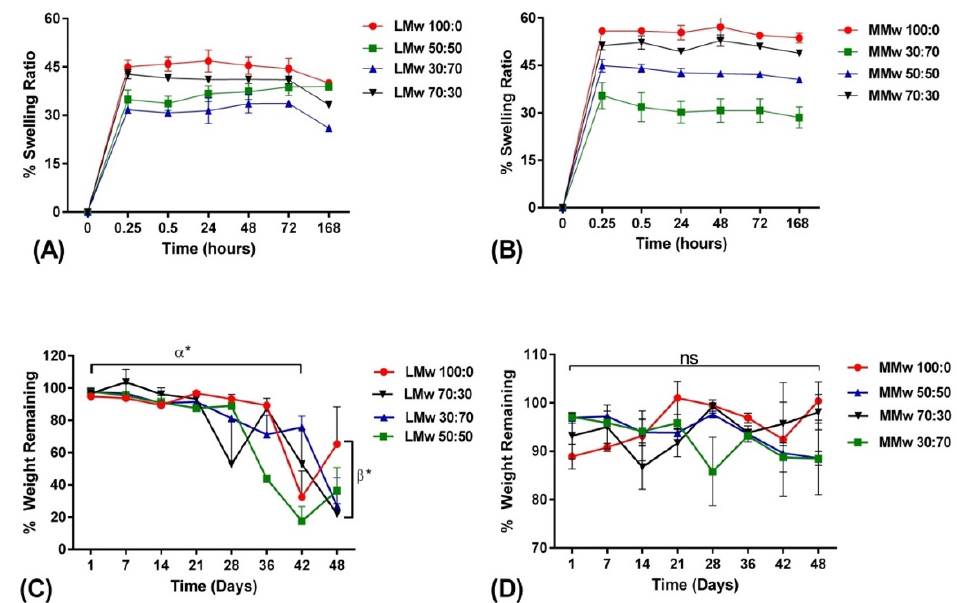
Figure 5. Swelling percentage of ( A ) LMw and ( B ) MMw CH and composite membranes performed over a period of 168 h. Weight remaining percentage of ( C ) LMw and ( D ) MMw composite mem- branes, performed over an experimental time period of 48 days. Shown values are mean ± SD ( n = 3).